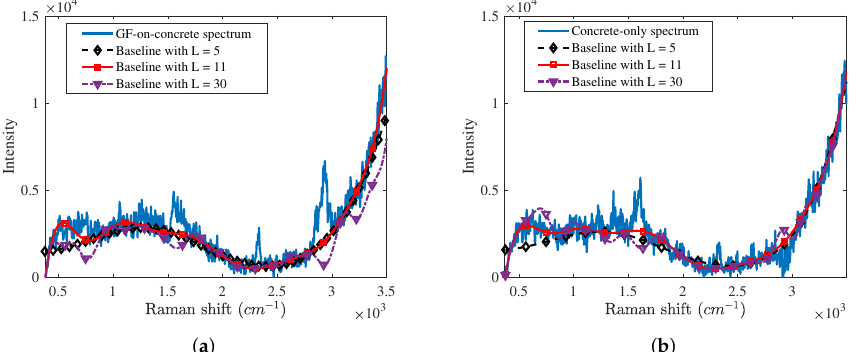
Figure 3. Baselines estimated by the proposed algorithm with 5, 11 and 30 broad Gaussian vectors from ( a ) the GF-on-concrete spectrum and ( b ) the concrete-only spectrum.